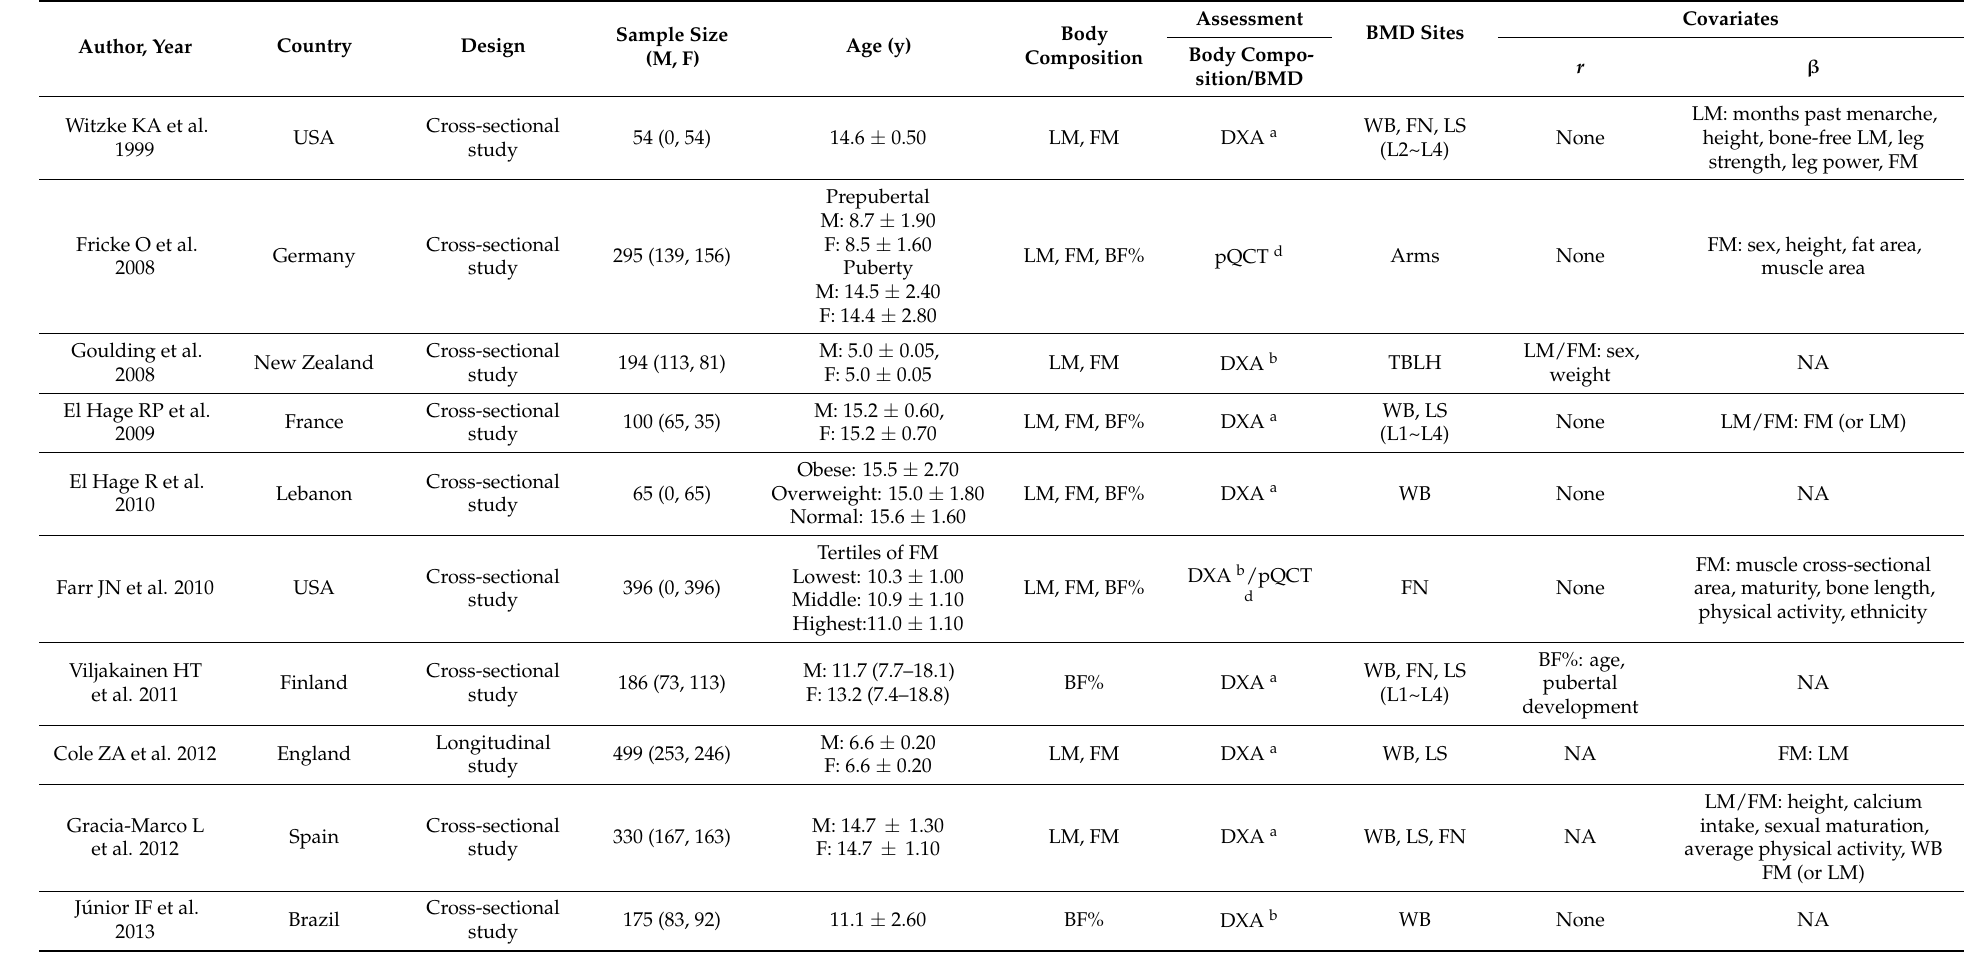
Table 1. Characteristics of the studies included in the systematic review and